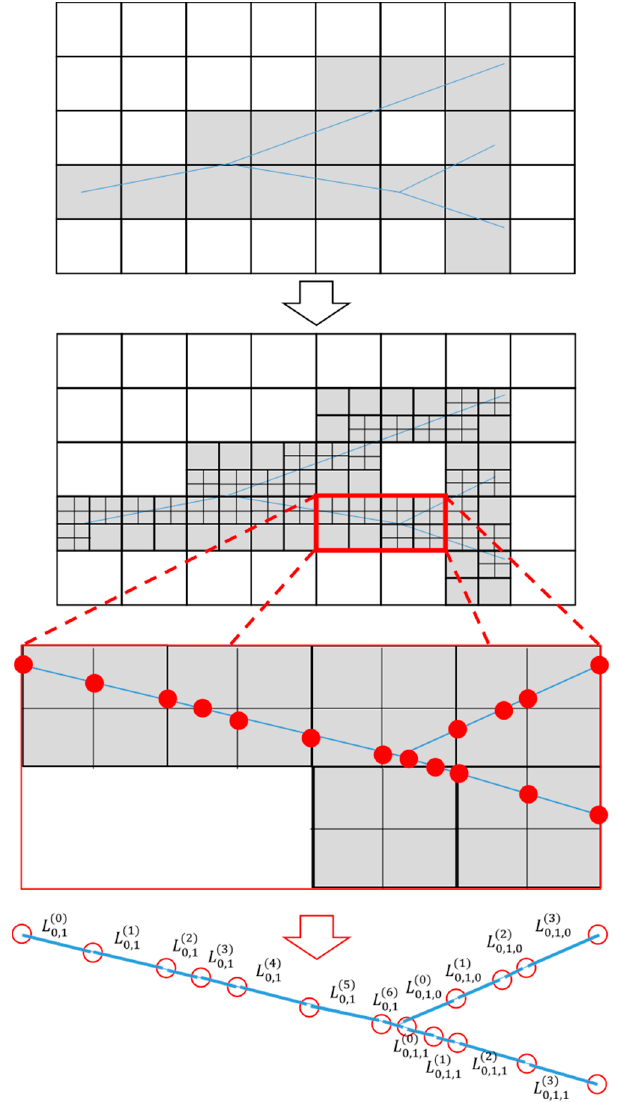
Figure 4. Grid refinement and discretization of each crack pathway leg into segments. The cells intersected by the pathway are repeatedly refined until the cells that the crack intersects become sufficiently small. Each segment intersects only one grid cell.